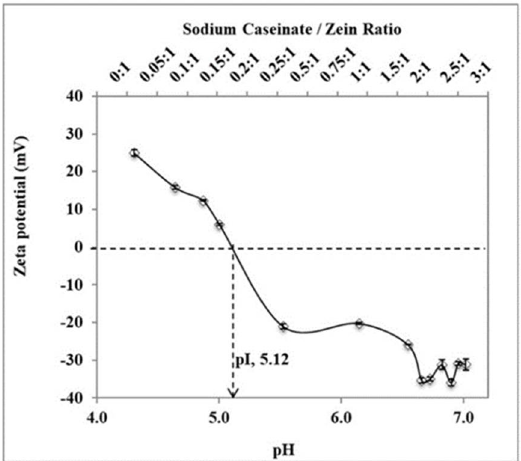
Figure 3. A plot of zeta potential against pH as sodium caseinate/zein ratio varied from 0:1 to 3:1. Zeta potential shifted from positive values to negative values as sodium caseinate/zein ratio increased. Isoelectric point (pI, pH at which zeta potential is zero) was extrapolated to be 5.12. The experimental data were obtained from the nanoparticles prepared from three different batches ( n = 3); symbols represent mean values while error bars represent standard deviation (SD).